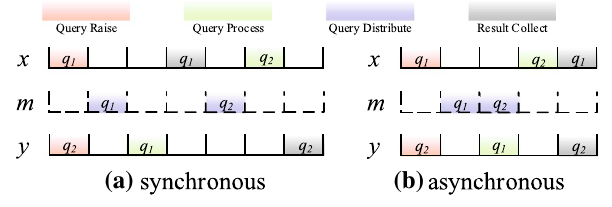
Fig. 6 Comparisons between execution modes